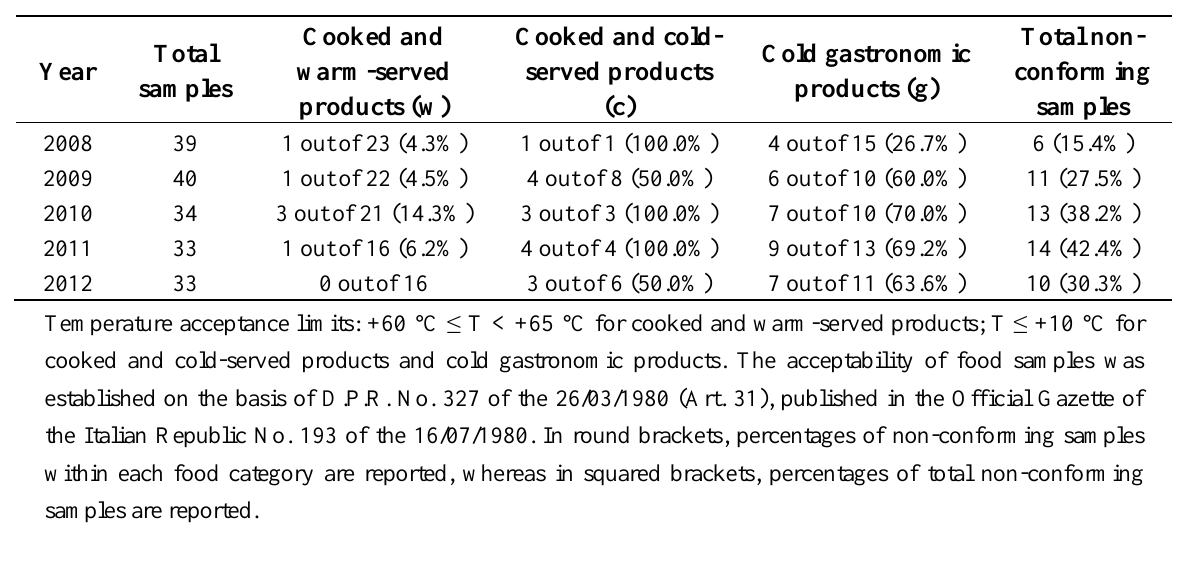
Table 3. Percentages of non-conforming samples based on their temperature